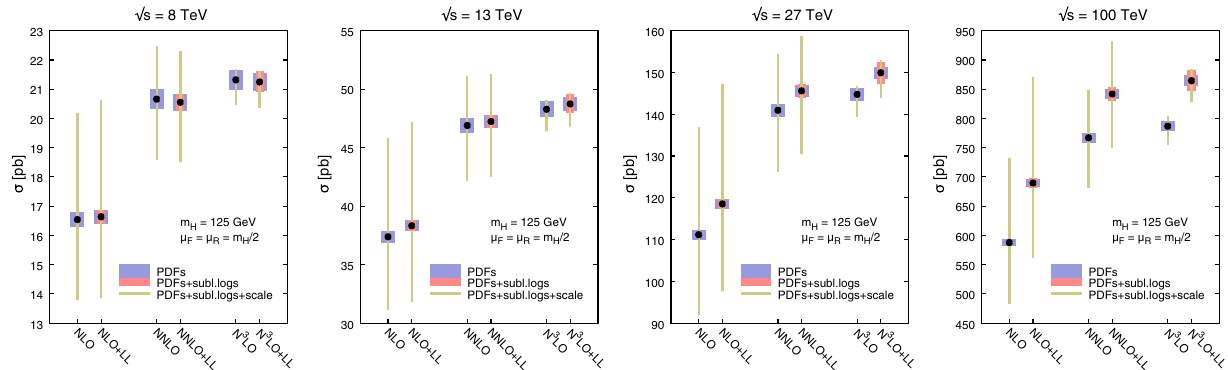
Fig. 8 Perturbative progression of the Higgs cross section for four √ s = { 8 , 13 , 27 , 100 } TeV. In each plot the NLO, collider energies NLO+LL,NNLO,NNLO+LL,N 3 LOandN 3 LO+LLresultsareshown.